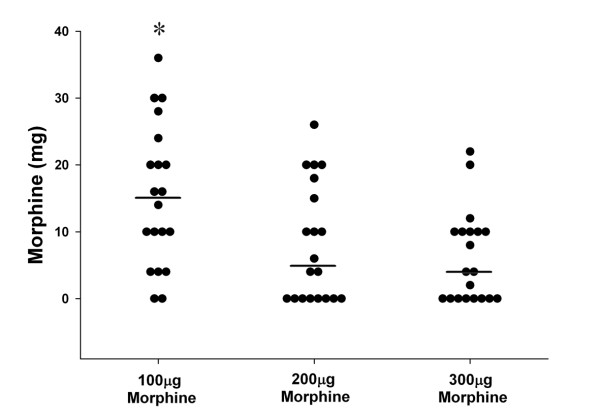
Dot plot of postoperative requirement for supplemental morphine over the first 24 postoperative hours for each patient in each group. The middle line for each group represents the median value. * Indicates significantly higher morphine requirements compared to the 200 μg and 300 μg IT Morphine groups (P = 0.001, Kruskall-Wallis one way ANOVA on ranks).